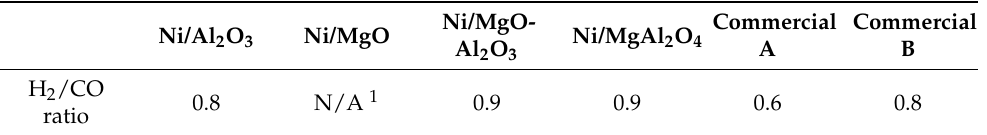
Table 2. H 2 /CO ratio of Ni catalysts with various supports (reaction conditions: Temp. = 750 °C,